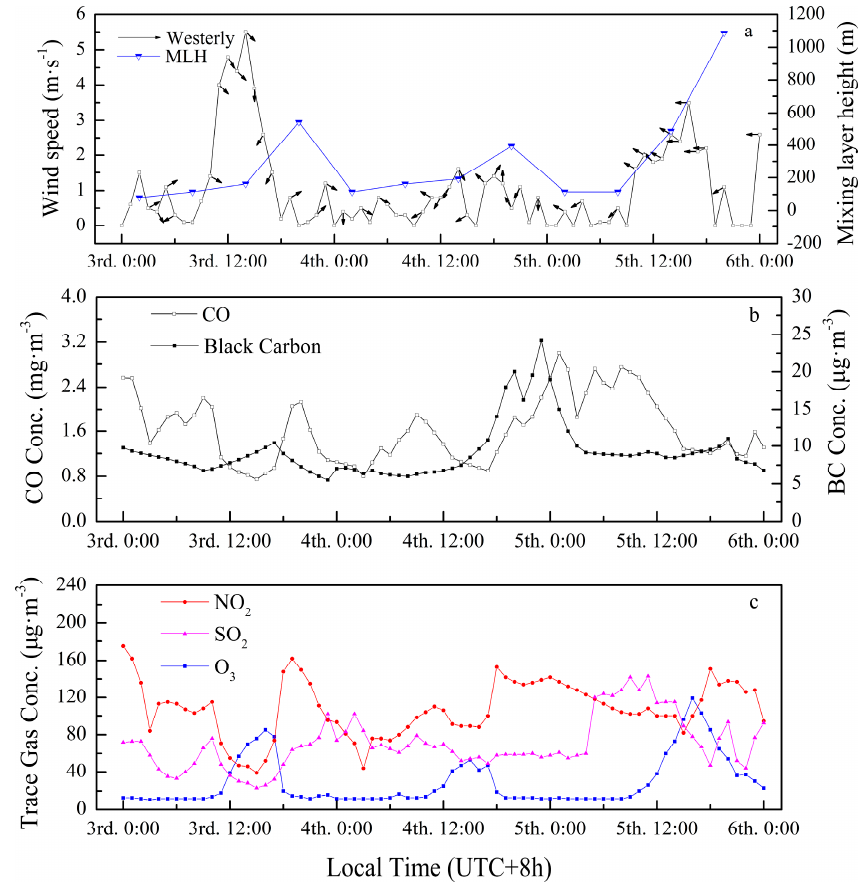
Figure 6. Concentration of trace gases averaged from three sites and black carbon with meteorological parameters on three consecutive winter days from 3 January to 5 January 2014: ( a ) hourly variations of wind speed and mixing layer height; ( b ) hourly variations in mass concentrations of CO and black carbon; ( c ) hourly variations in mass concentrations of NO 2 , SO 2 , and O 3 .